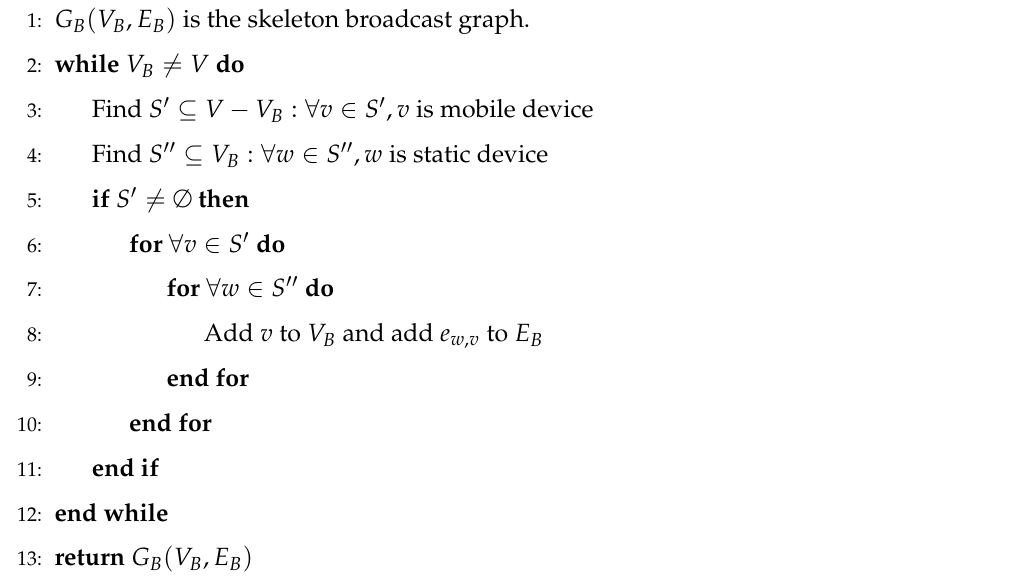
Algorithm 3 Pseudocode for Grafting Mobile Device on to Skeleton Broadcast